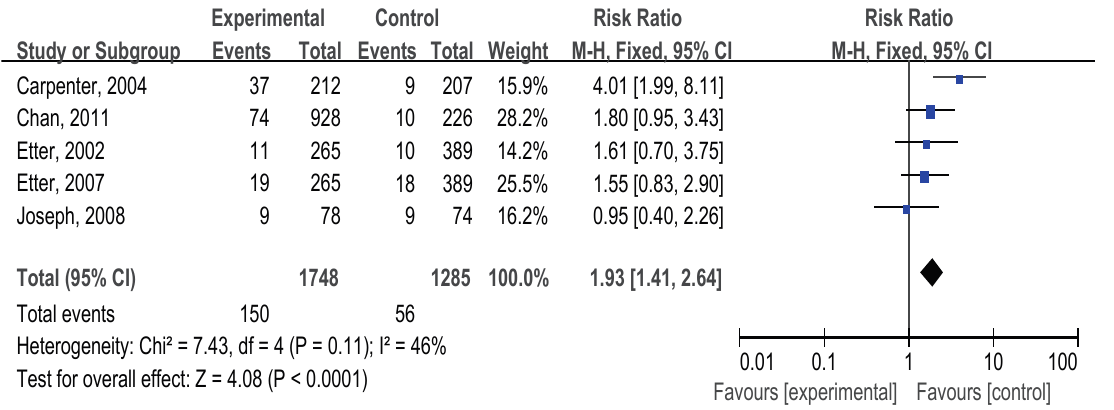
Figure 3. Forest plot of comparison: reduction support plus medication vs. no